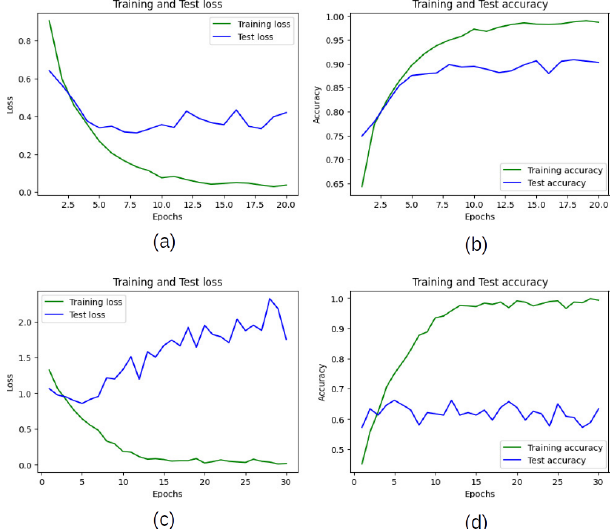
Figure 7. Training and validation performance scores of the transfer learning AlexNet for experiment: (a) training and test loss for the experiment (i); (b) training and test accuracy for the experiment (i); (c) training and test loss for the experiment (ii), and (d) training and test accuracy for the experiment (ii).